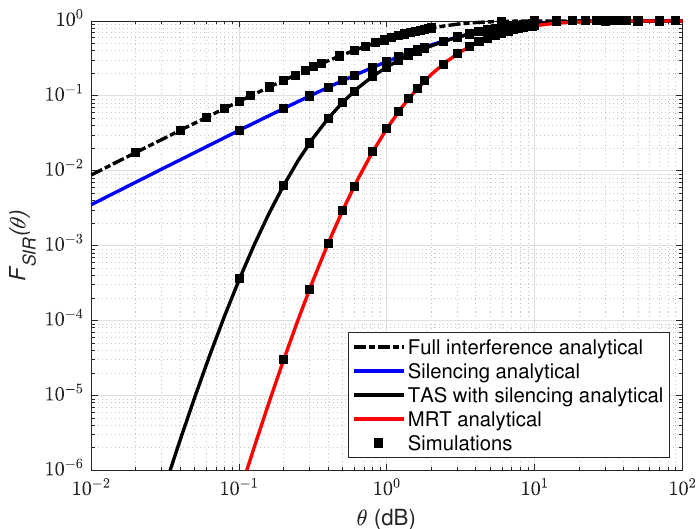
Figure 2. Overview of SIR distribution for full interference, silencing, TAS with silencing and MRT schemes as a function of θ . We set k = 6 RRH in